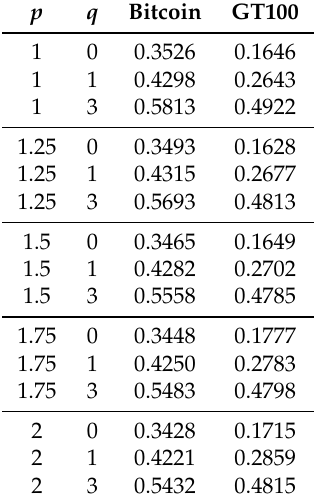
Table 1. L p -norm F-transform of Bitcoin and GT100 time series For five values p and three orders q ∈ { 0,1,3 } the table shows ratios L ( f , f ( r ) ) with f ∈ { Bitcoin , GT 100 }